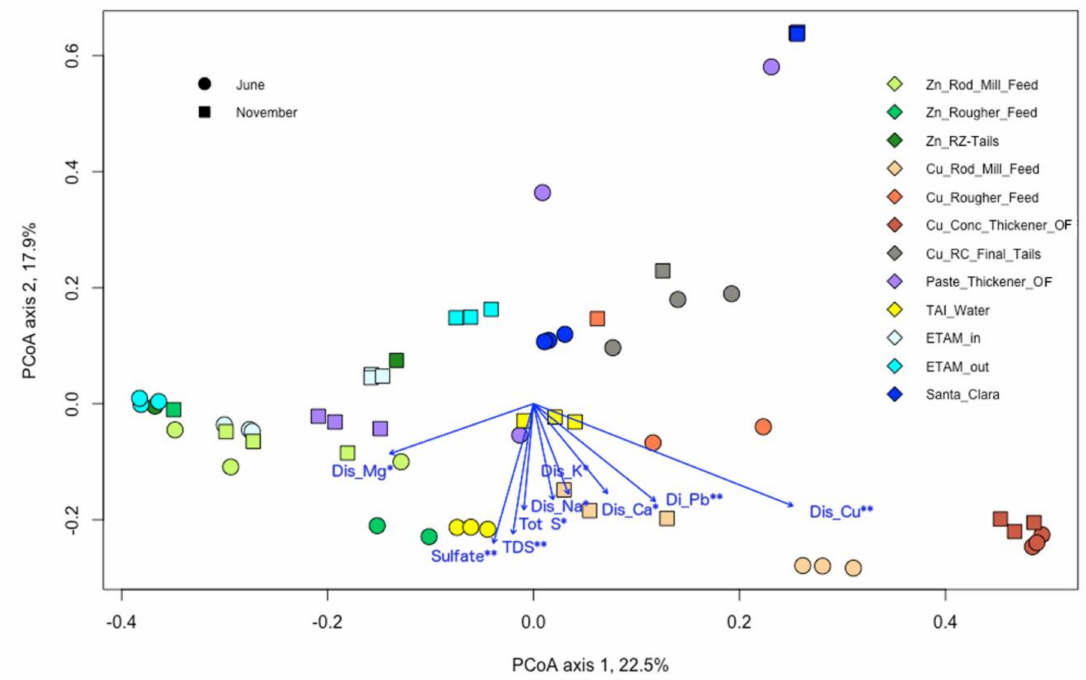
Figure 12. Principal coordinate analysis (PCoA) of the bacterial communities identified from the Portuguese mine zinc and copper plants and water circuit samples by the amplicon sequencing. Statistically significant (* p < 0.01, ** p < 0.001) chemical variables with 9999 permutations are